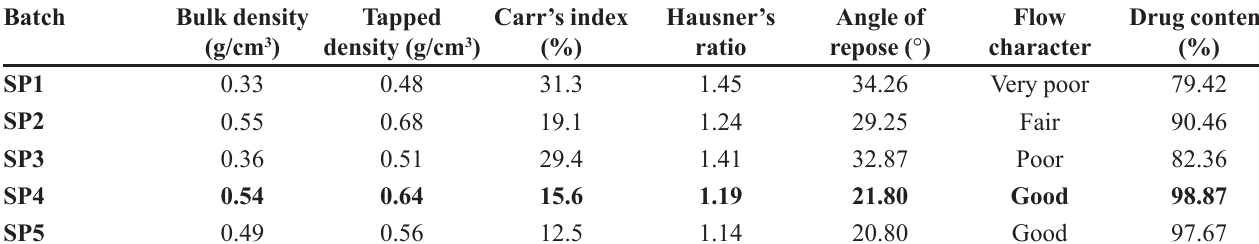
TABLE III - Evaluation results of solid SMEDDS batches Batch